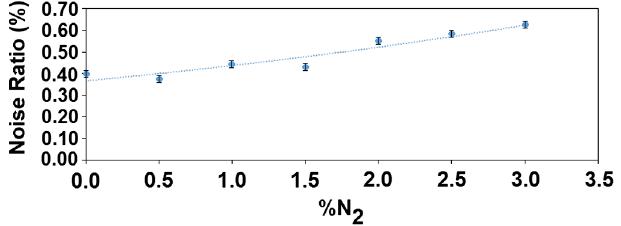
FIG. 16. Noise ratio as a function of N 2 = H 2